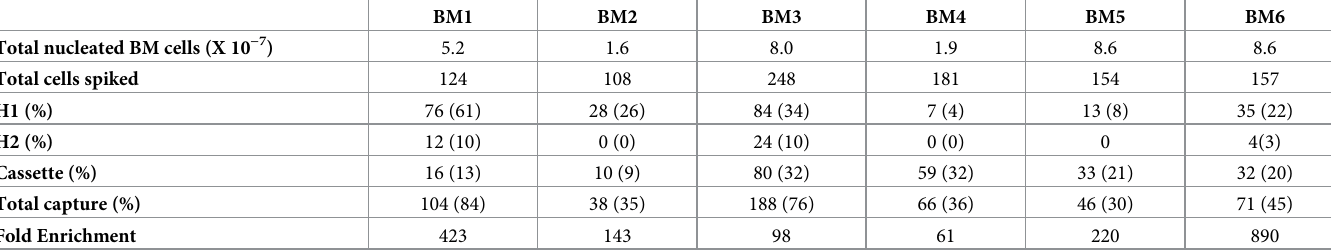
Table 1. Harvest cell counts from spiking experiments using labeled SKBR3 cells in BM.